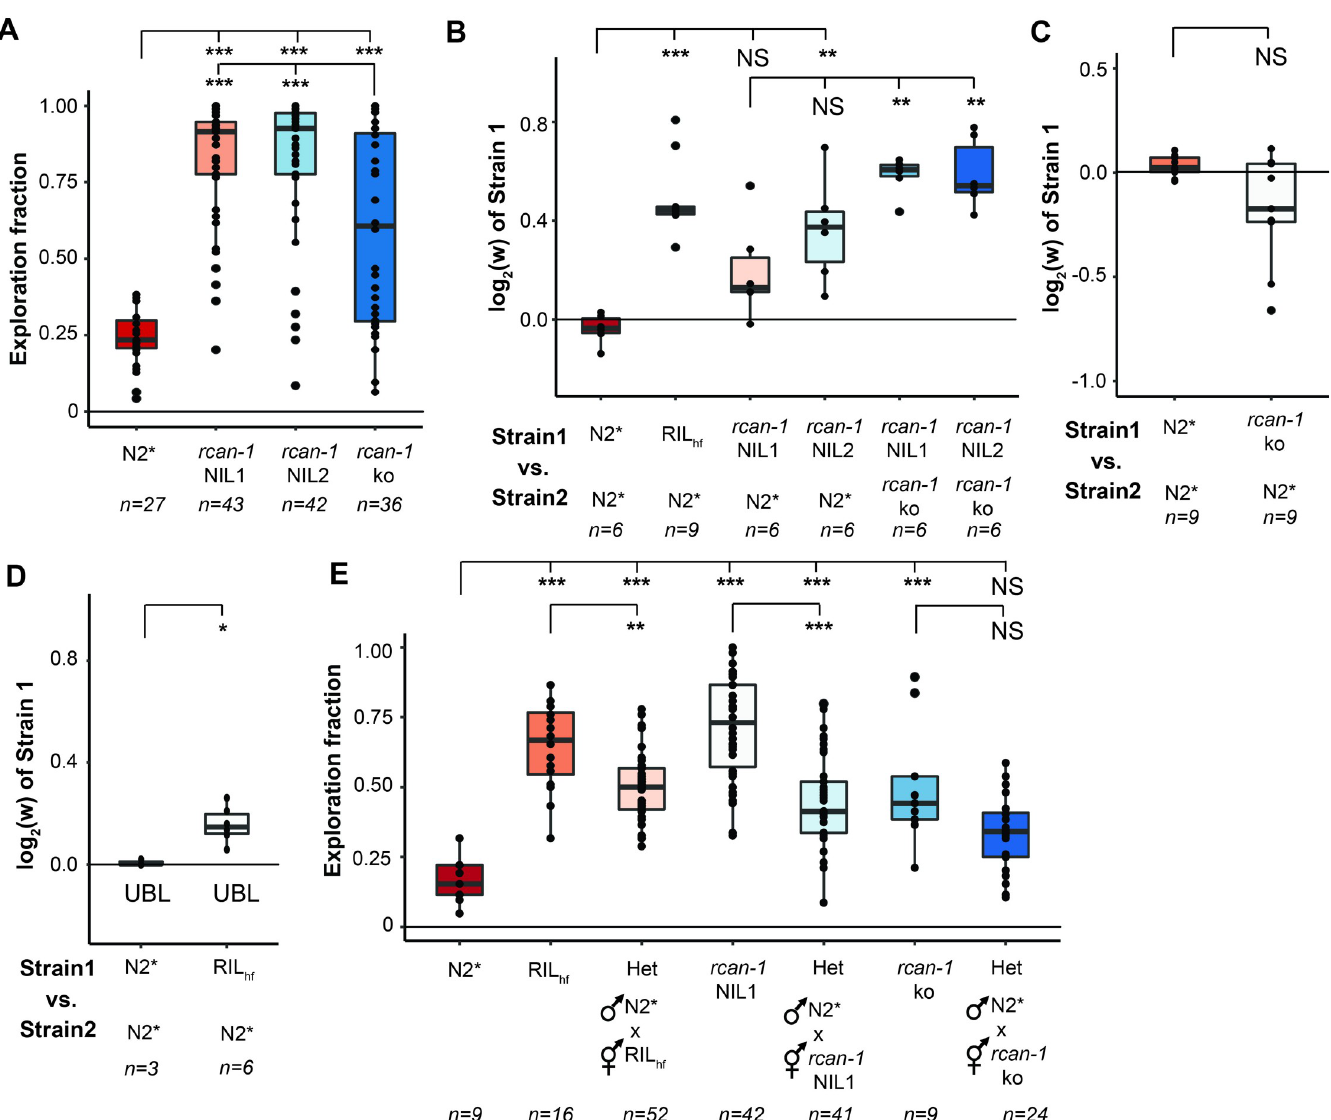
Fig 7. The rcan-1 rearrangement allele is not a loss of function allele but its complexity is necessary for fitness advantage and active exploration behavior. (A) A large deletion of the rcan-1 coding region was created using CRISPR/Cas9 genomic editing of the N2 � strain. The rcan-1 knockout modified exploration behavior but did not phenocopy the rcan-1 NIL strains ( ��� : p < 0.001. one-way ANOVA tests followed by Tukey’s honest significant difference test). (B) Competition experiments demonstrated that a strain carrying an rcan-1 deletion allele was less fit than the rcan-1 NIL strain (NS: Not significant; �� : p < 0.01; ��� : p < 0.001. one-way ANOVA tests followed by Tukey’s honest significant difference test). (C) Competition experiments suggested that a strain carrying an rcan-1 deletion allele does not show fitness advantage when compete against rcan-1 wild-type strain. (NS: Not significant. Unpaired Mann-Whitney-Wilcoxon Test). (D) Plates seeded with uniform bacteria lawn that suppress aggregation behavior of N2 � do not fully suppress fitness advantage of rcan-1 rearrangement allele. ( � : p < 0.05. Unpaired Mann-Whitney-Wilcoxon Test). (E) F1 heterozygotes N2 � x RIL hf animals and N2 � x rcan-1 NIL1 animals show significantly lower exploration fraction than RIL hf and rcan-1 NIL1. (NS: Not